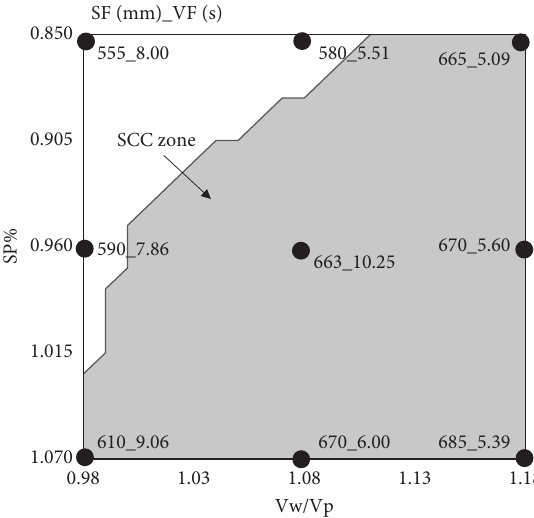
Figure 7: Results of SCC with cement and FA as